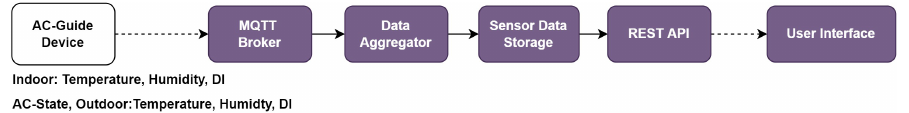
Figure 15. Function flow for AC-Guide in platform.